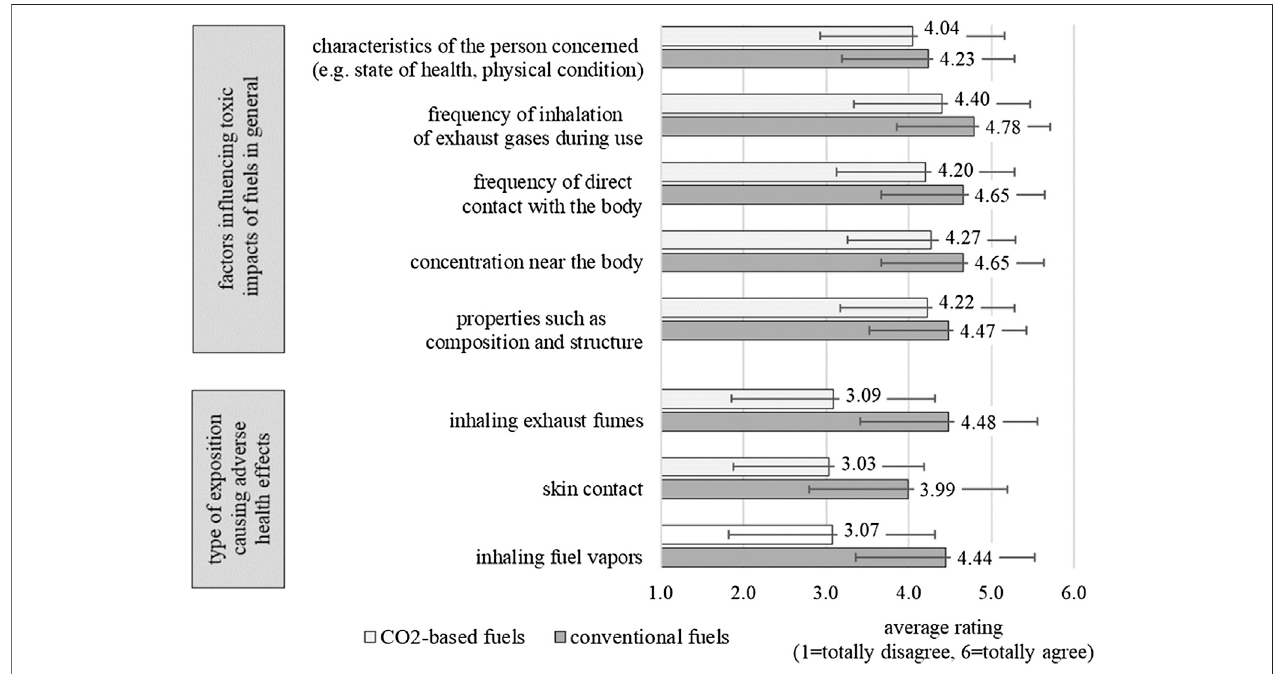
FIGURE 3 | Perceived negative impacts of CO 2 -based fuels on risk targets compared to conventional fuels.